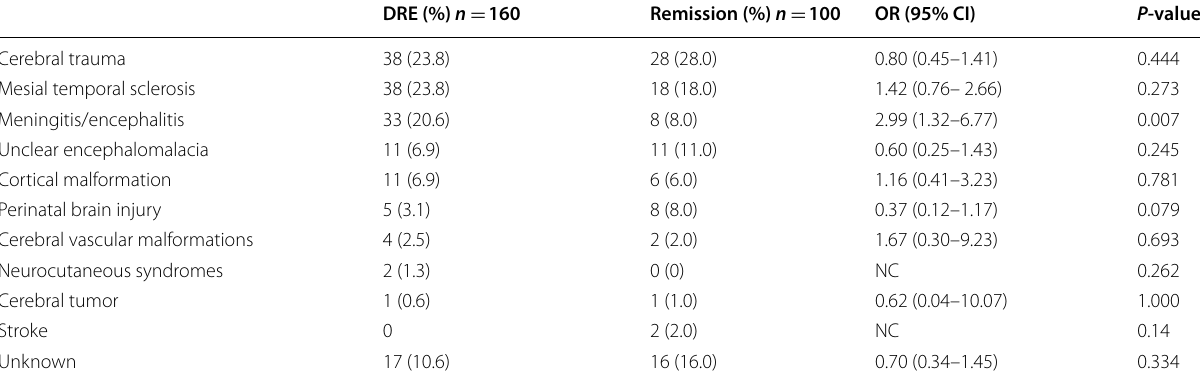
Table 6 Comparison of patients with drug-resistant epilepsy and with 1-year remission at the end of the study by etiology of symptomatic